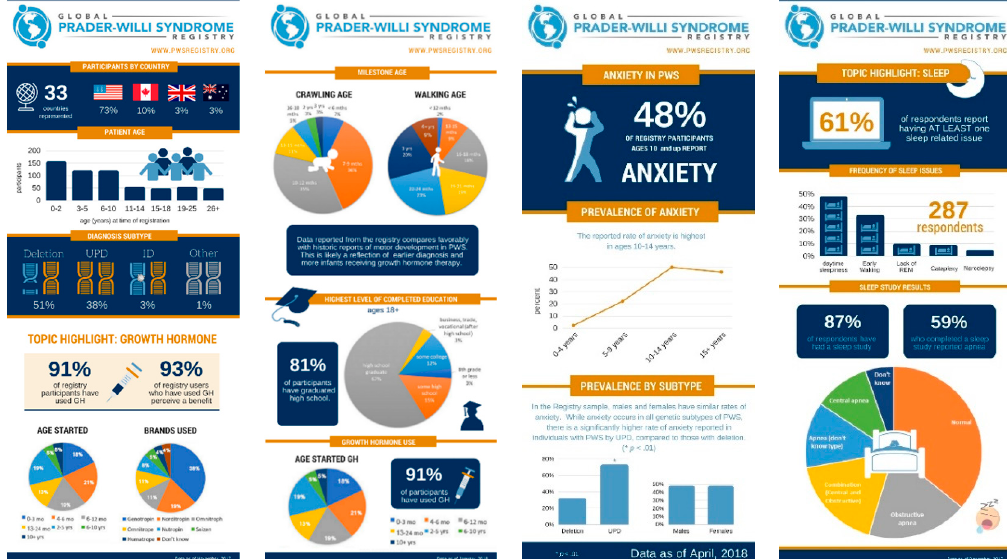
Figure 4. Infographics of Registry data shared with the PWS community. De-identified aggregate data is exported from the Registry, analyzed, and represented in infographics, and shared through social media, print newsletters, and other communications. Each infographic is designed to highlight a specific topic area of interest to PWS families, clinicians, and other stakeholders within the PWS community. Infographics and accompanying descriptions are available at https://www.fpwr.org/blog